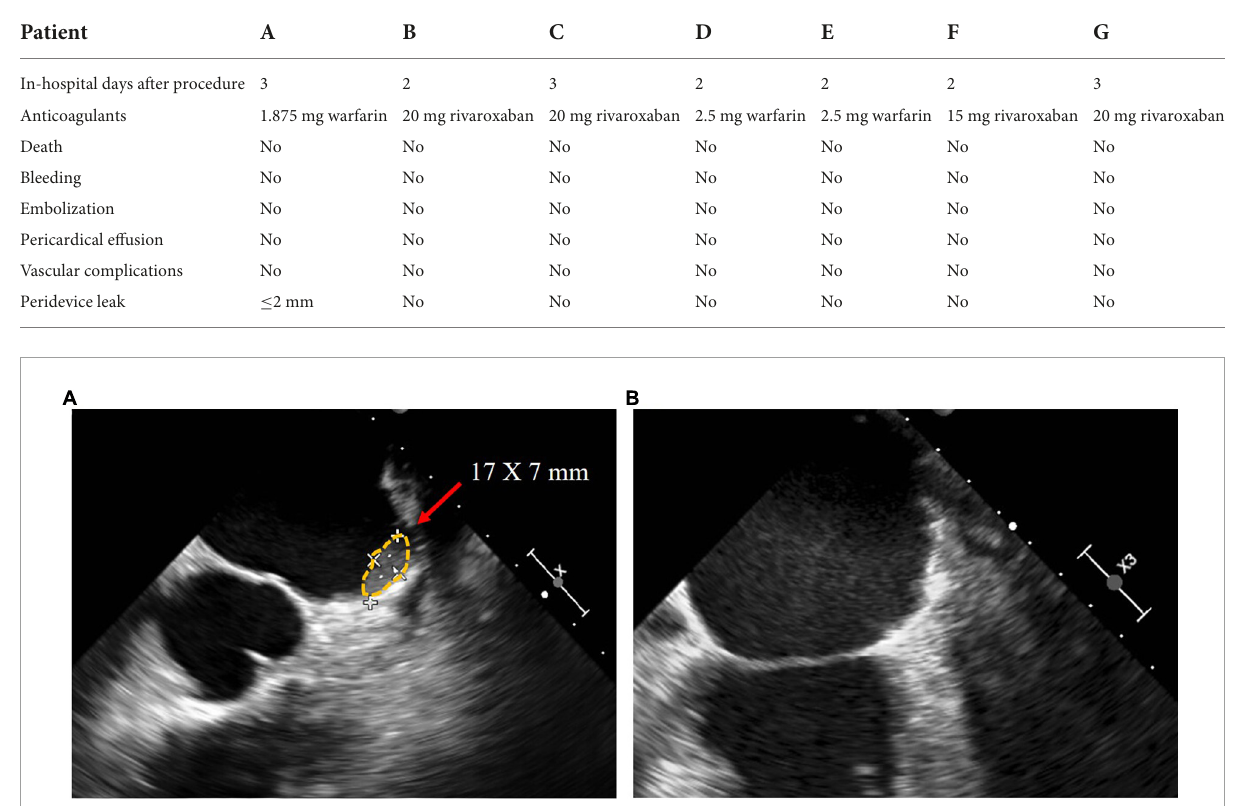
TABLE 3 Periprocedural outcomes.